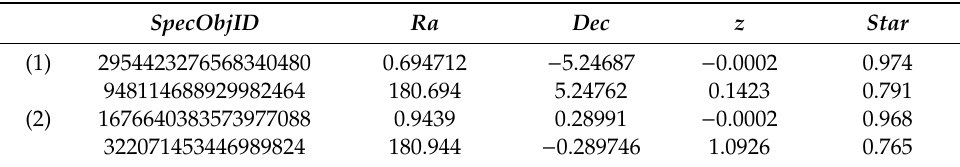
Table A9. Pairs of opposite stars in [39] with accuracy of 0.001 ◦ for ra and dec . SpecObjID is ID of optical spectroscopic object in